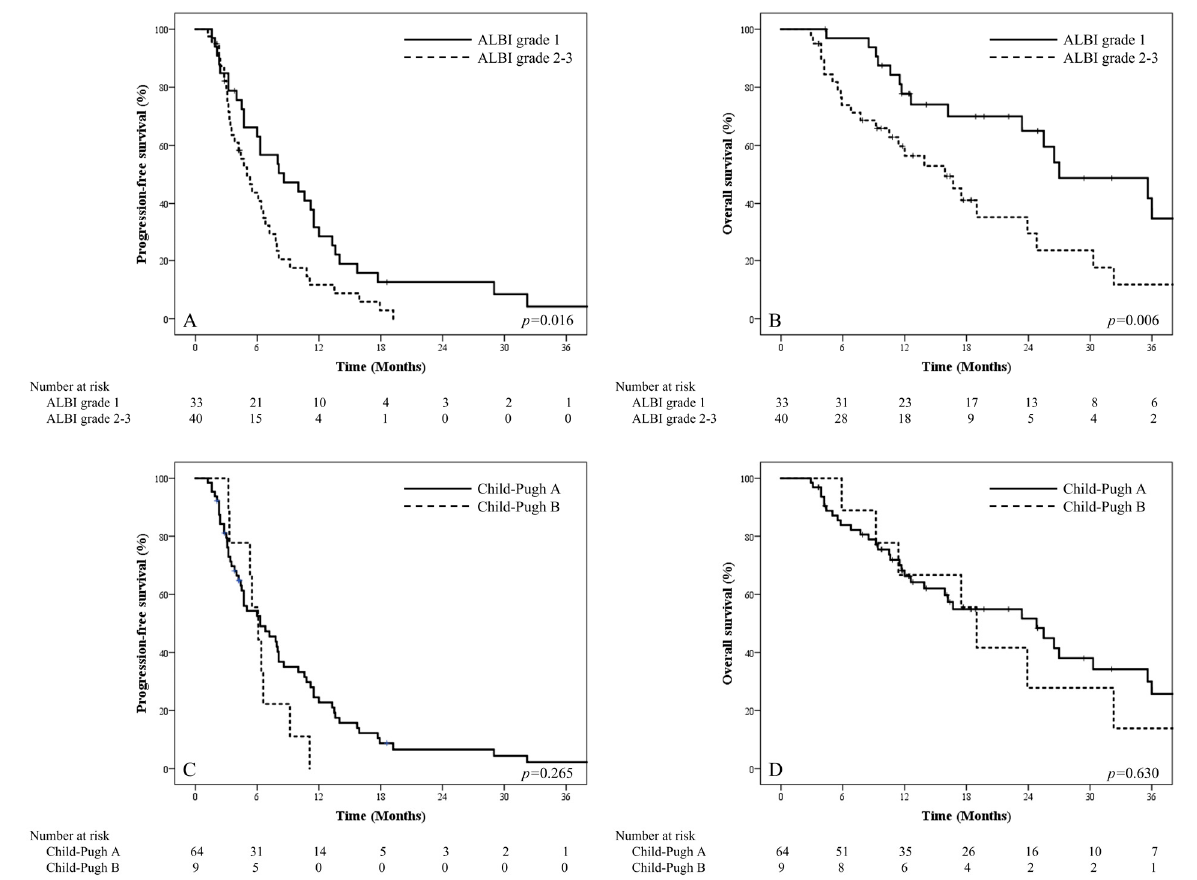
Figure 2. Kaplan–Meier survival curves of PFS and OS according to ALBI grade and C–P class with the number at risk are generated. The two-year PFS rate and OS rate for ALBI grade 1 and ALBI grade 2–3 were ( A ) 12.8% and 0.0%, respectively, and ( B ) 65.0% and 29.4%, respectively. The two-year PFS rate and OS rate for C–P class A and C–P class B were ( C ) 6.6% and 0.0%, respectively, and ( D ) 51.6% and 27.8%, respectively.